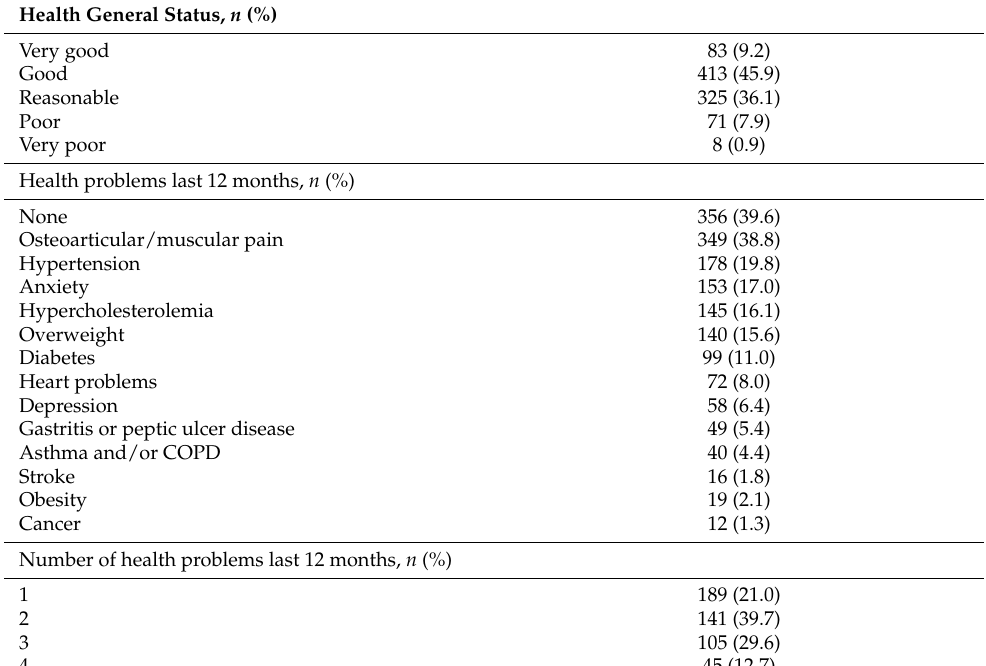
Table 2. Self-perceived health general status and health problems of the